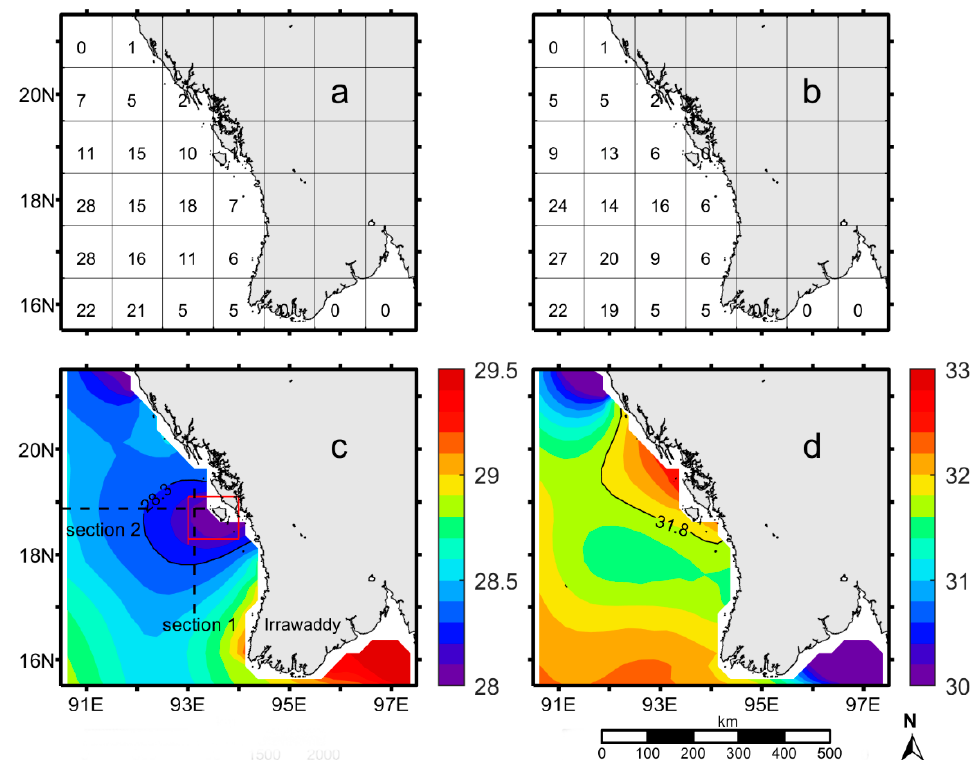
Figure 2. Sample amounts of surface temperature ( a ) and salinity ( b ) in spring (March-May) in a 1 ◦ × 1 ◦ grid; ( c ) and ( d ) are climatological surface temperature (unit: ◦ C) and salinity (unit: psu) in the same period. In Figure 2c, the dotted lines indicate the locations of Section 1 (93.375 ◦ E, 16.875–19.125 ◦ N) and Section 2 (90.125–93.375 ◦ E, 18.875 ◦ N), the red box (93.0–94.0 ◦ E, 18.5–19.0 ◦ N) represents the core area of upwelling, and the solid line is the 28.3 ◦ C isotherm. The solid line in Figure 2d is the 31.8 psu isohaline. Temperature and salinity data are from climatological monthly data set of World Ocean Atlas 2018 (WOA18).